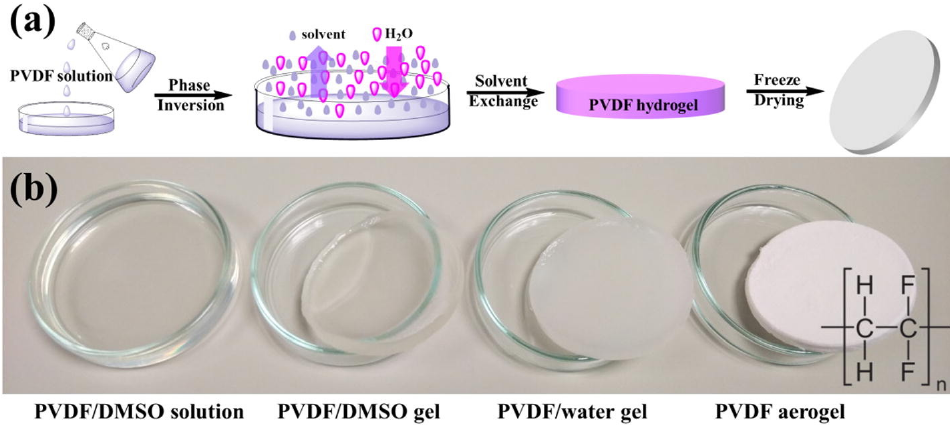
Figure 6. Illustration of the phase inversion method for aerogel fabrication: ( a ) schematic showing the solvent exchange and phase inversion process and ( b ) digital photos showing sample phase changes and aerogel formation during the fabrication. Reproduced with permission from [45], ©2017 Elsevier